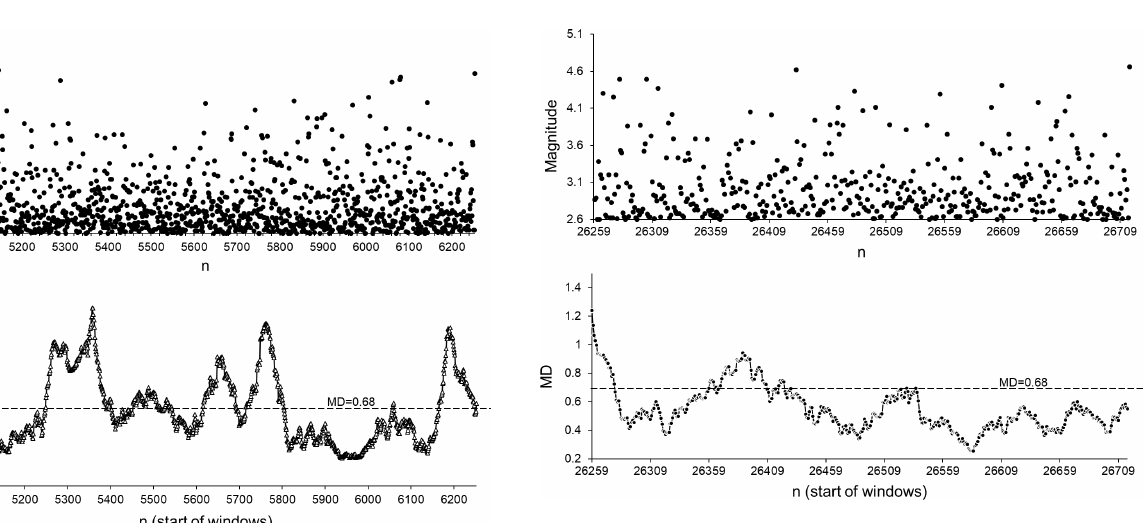
Figure 15. Magnitudes and MD values calculated for the non- aftershock part of the SC catalogue from 24 May 2006 (sequential number in SC catalogue 26259) to 5 August 2007 (sequential num- ber in SC catalogue 26717). Average MD values are calculated for 50-data windows shifted by one data